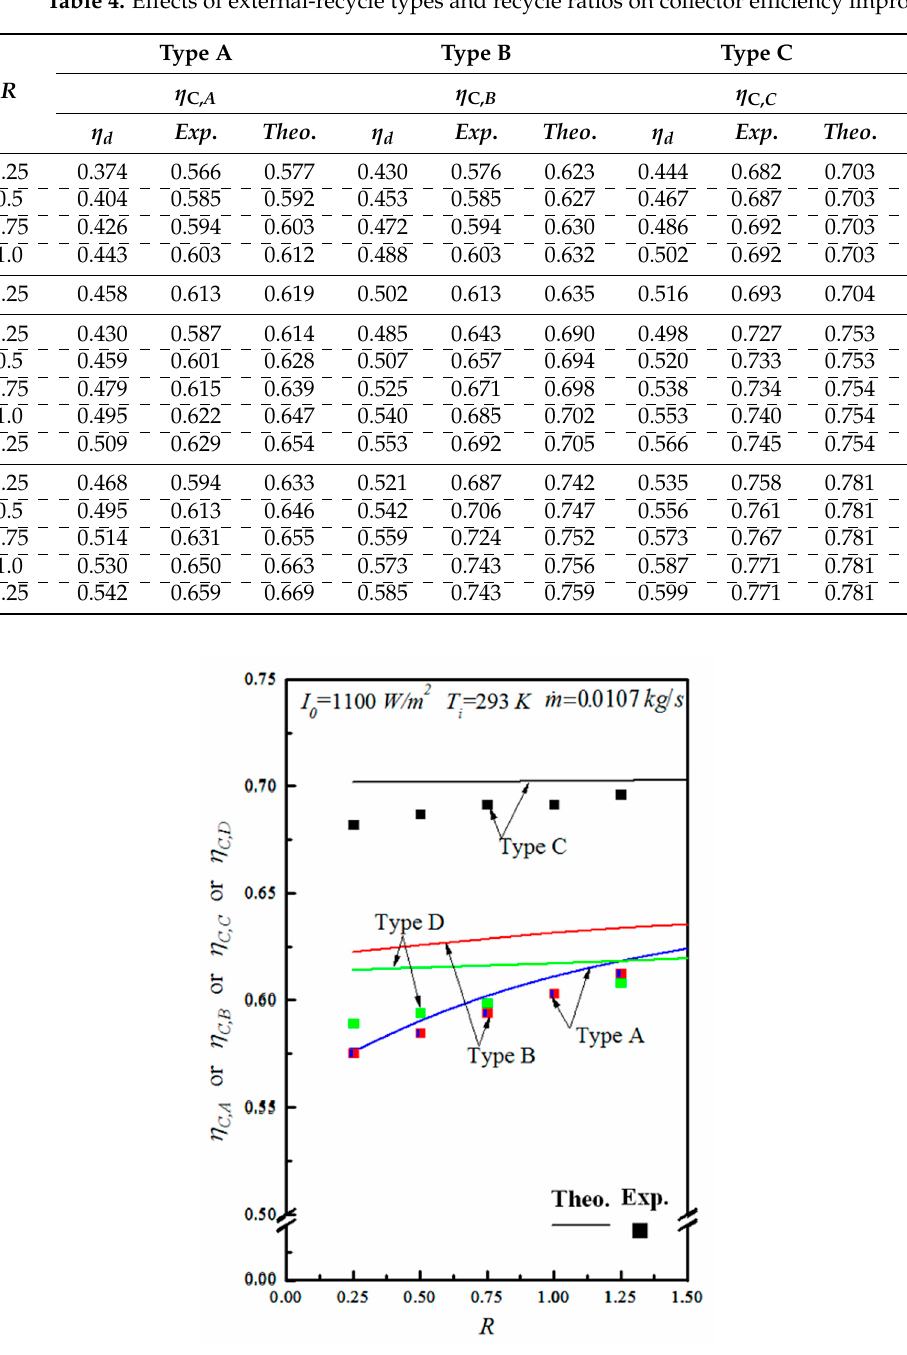
Figure 12. Effect of the recycling ratio on collector efficiency of four types.